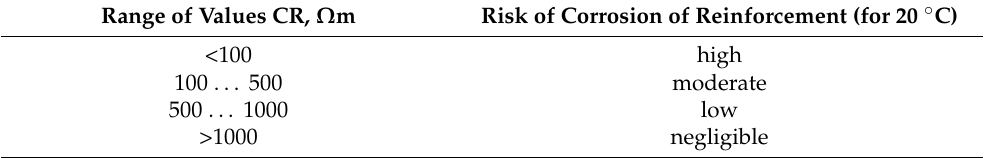
Table 2. Range of CR values used to estimate the probability of corrosion of steel reinforcement bars in concrete